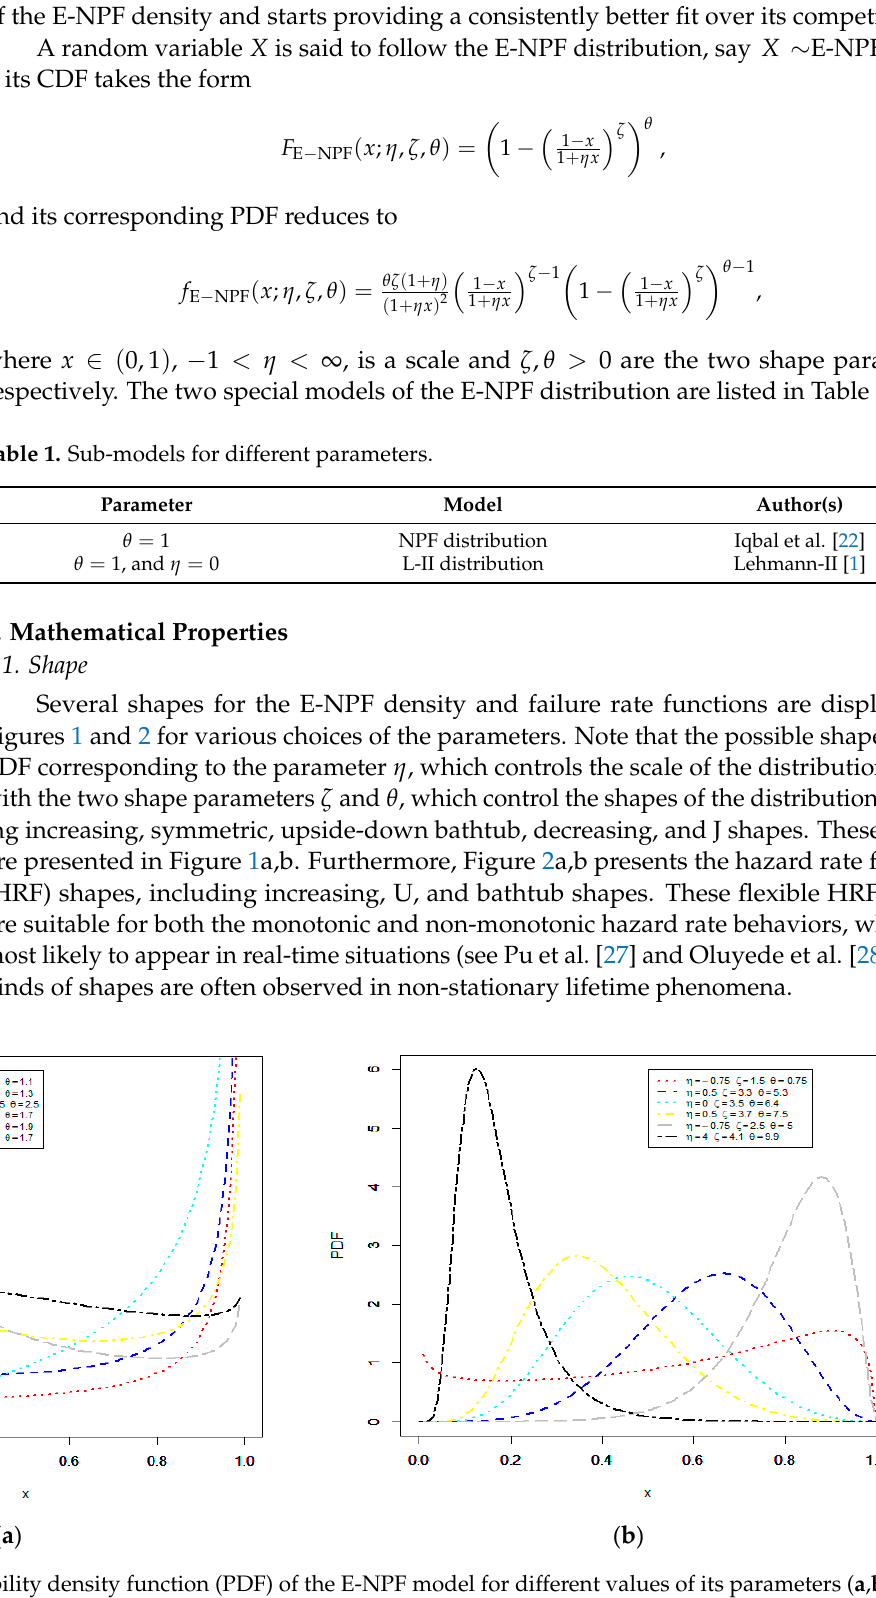
Figure 1. Plots of the probability density function (PDF) of the E-NPF model for different values of its parameters ( a , b ).